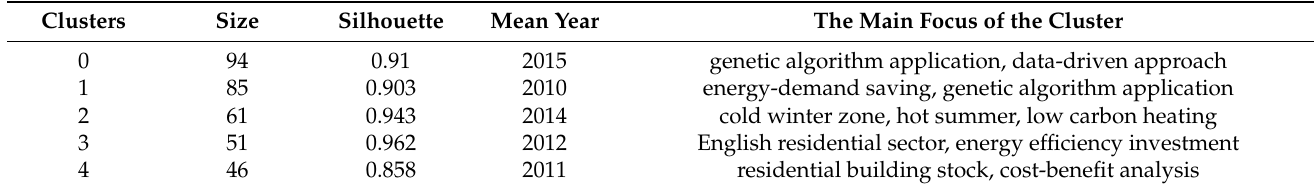
Table 2. Main clusters and their content